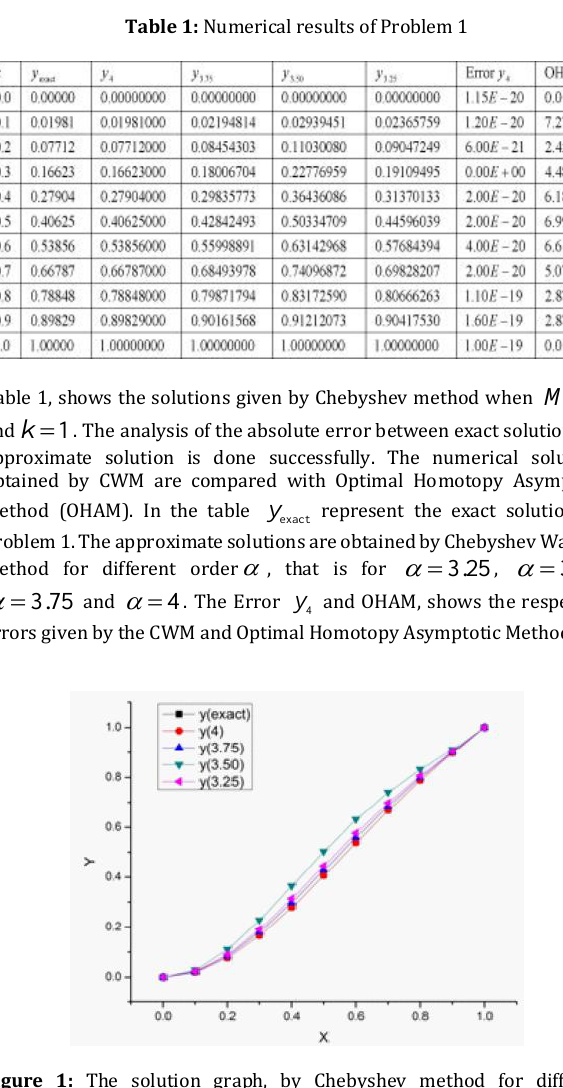
Figure 1: The solution graph, by Chebyshev method for different fractional order  Problem 2. Given fractional order BVP